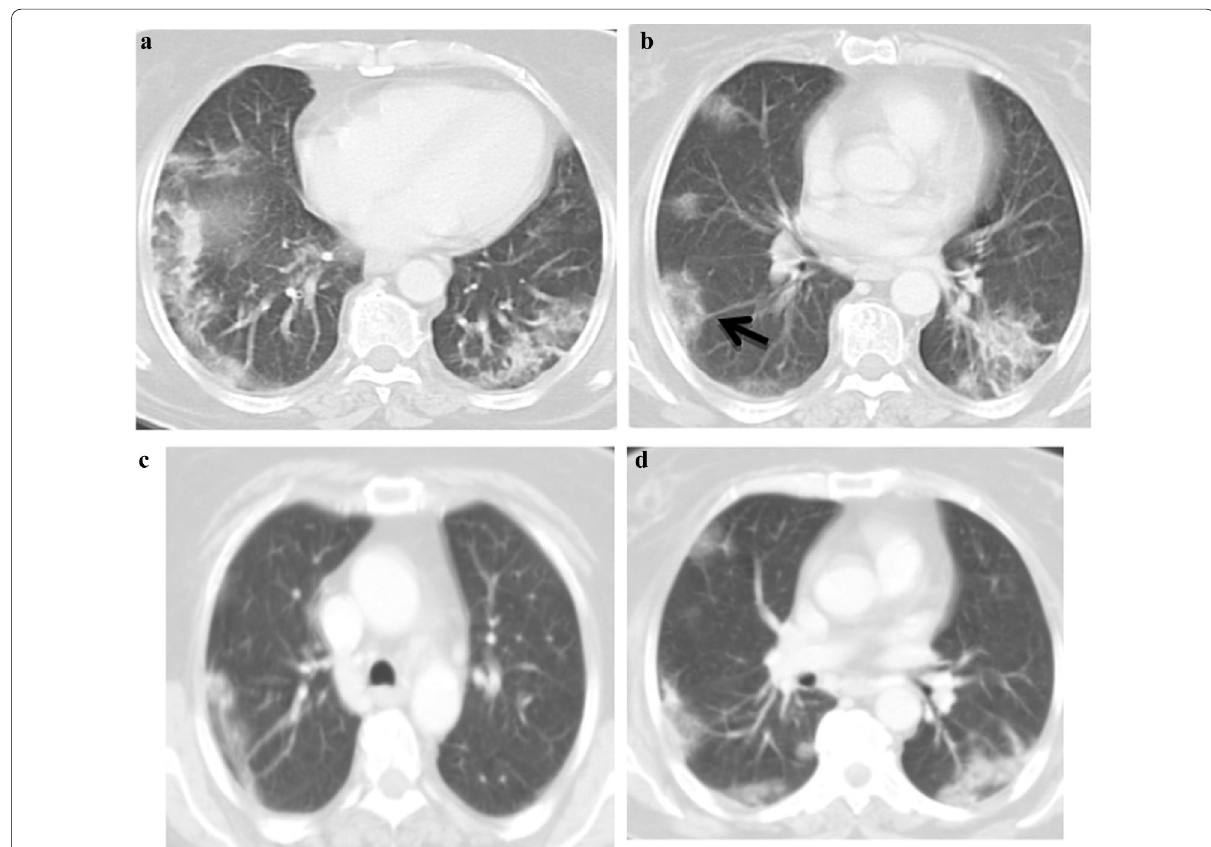
Fig. 1. A 52-year-old female known history of cancer colon presented with anosmia, cough, fever, diarrhea and myalgia at September 2020 and positive PCR for COVID 19 infection, a and b post-contrast CT axial cuts shows bilateral patchy subpleural ground glass opacities with right lower lobe Atoll sign (arrowed). The patient diagnosed as COVID 19 infection with CT score severity: 10. Second infection dated March 2021 the patient presented with fever, cough, respiratory distress and myalgia with positive PCR test for COVID 19 infection. c and d postcontrast CT chest images show bilateral patchy subpleural ground glass opacities. The patient diagnosed as COVID 19 re-infection with CT severity score: